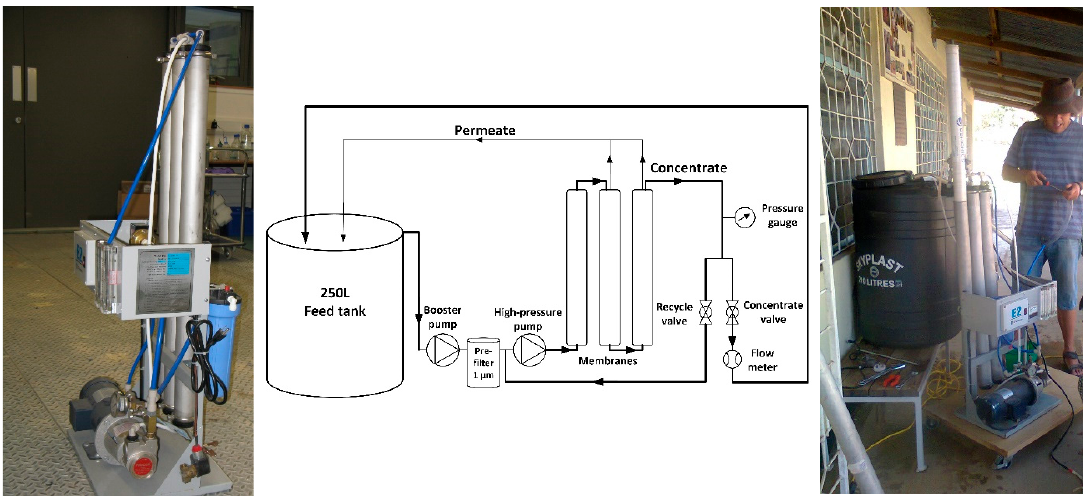
Figure 2. Left: photo of pilot-scale membrane system (GE Osmonics E2-2535TM, photos © Andrea Iris Schäfer) with three 2.5 inch modules in series; middle: schematic of the pilot-scale membrane system; right: set-up of the system at the Ngurdoto Defluoridation Research Station (NDRS) in Tanzania with feed tank.